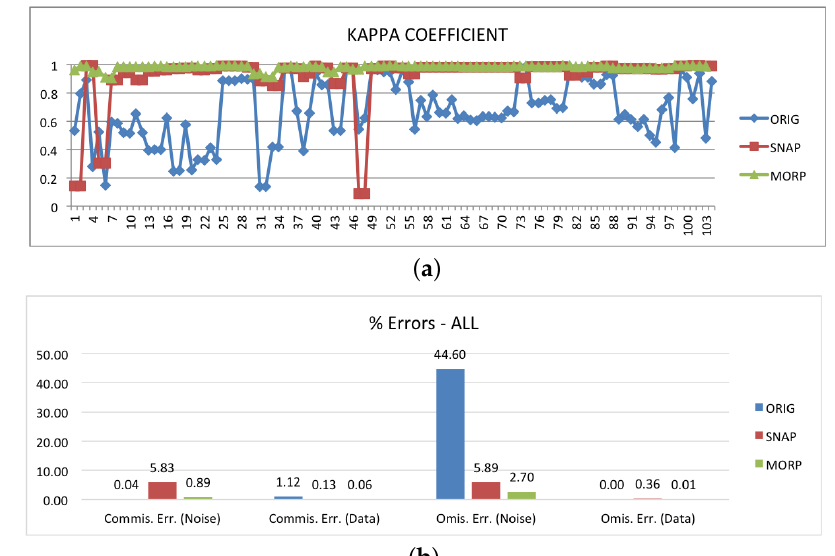
Figure 5. Performance assessment of the proposed method ( MORP ), compared to the original unmasked images ( ORIG ) and the images masked via SNAP’s ‘Remove GRD Border Noise’ module ( SNAP ): ( a ) plot of the Kappa coefficient per single image; ( b ) aggregated commission/omission errors for the entire dataset.